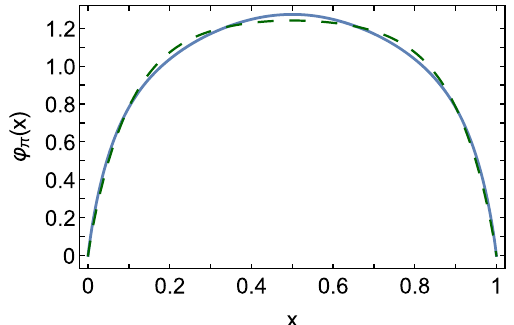
Fig. 2 Comparison of pion leading-twist two-particle DAs: ϕ π ( x ; ζ H ) computed using the DB kernel [60], solid blue curve; and Eq.(27), dashed green